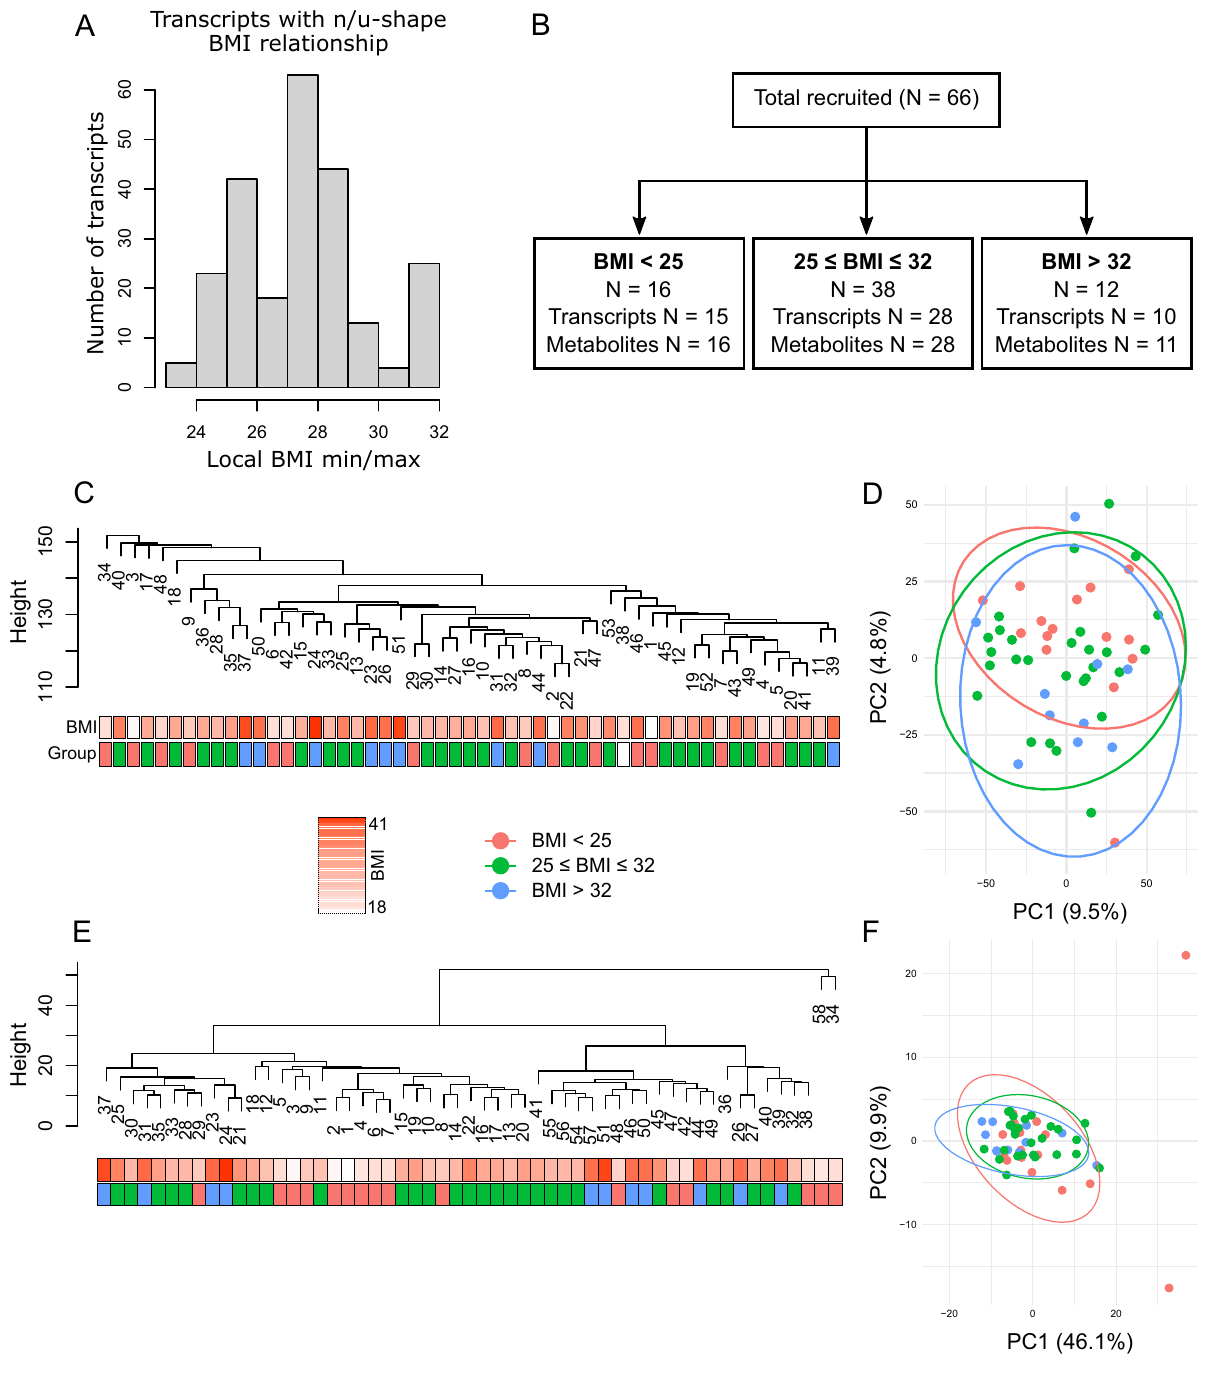
Figure 3. ( A ) Distribution of local BMI minima and maxima for transcripts whose expression display U or N-shape BMI dependence. ( B ) BMI groups definition with numbers of samples. ( C ) Hierarchical clustering of samples using transcriptomics data. ( D ) Principal component analysis of transcriptomics data: the first two components were plotted with 95% confidence interval for each BMI group. ( E ) Hierarchical clustering of samples using metabolomics data. ( F ) Principal component analysis of metabolomics data: the first two components were plotted with 95% confidence intervals for each BMI